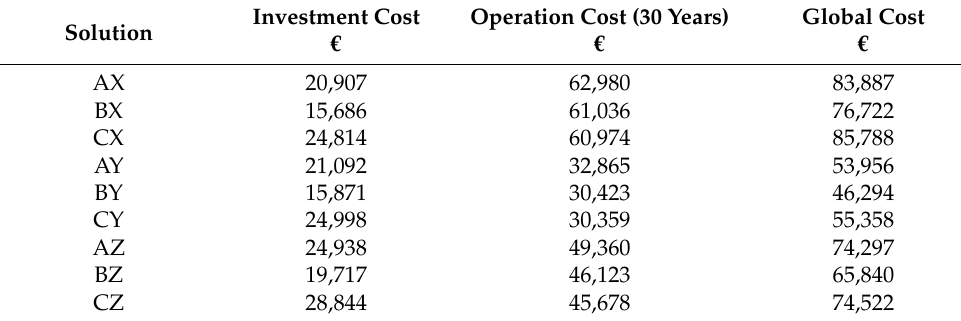
Table 8. Cost of the observed system